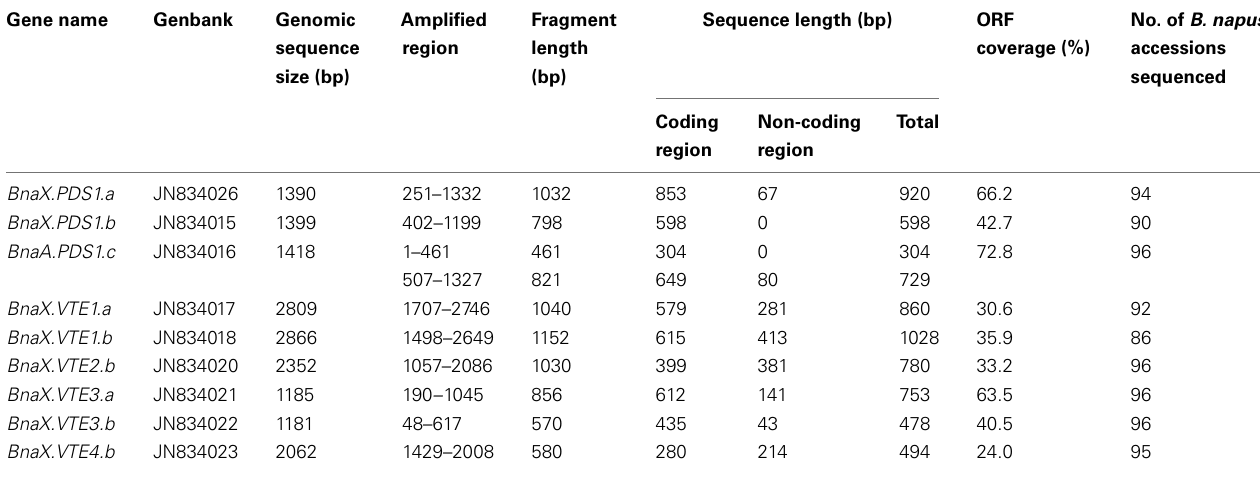
Table 4 |Tocopherol biosynthesis genes of B. napus , their genomic gene length, amplified gene region, total fragment length, and number of base pairs aligned after sequencing of the gene fragment of panel 1